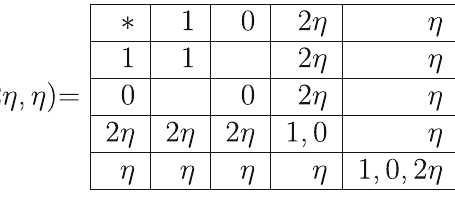
Fig. 4 Fusion rules satisfied by a double